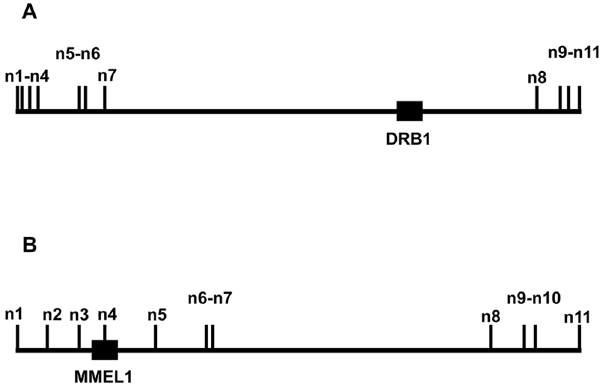
Figure 1. The positioning of the different SNPs used for the SNP-string analysis relative to the putative gene of interest for the DRB1 locus (A) and the MMEL1 locus (B) .